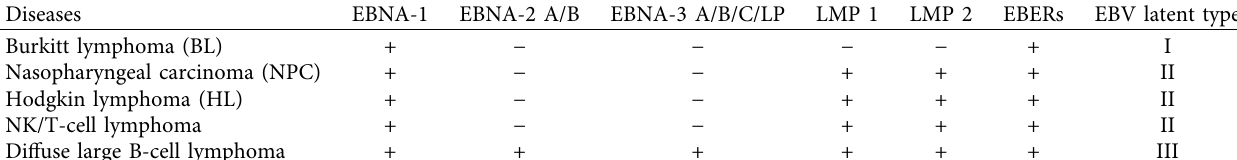
Table 2: Expression products in each of the latency states of EBV in EBV-associated neoplasms. Viral genes and small RNAs are observed in the different types of EBV latency that can be seen in the different neoplasms.